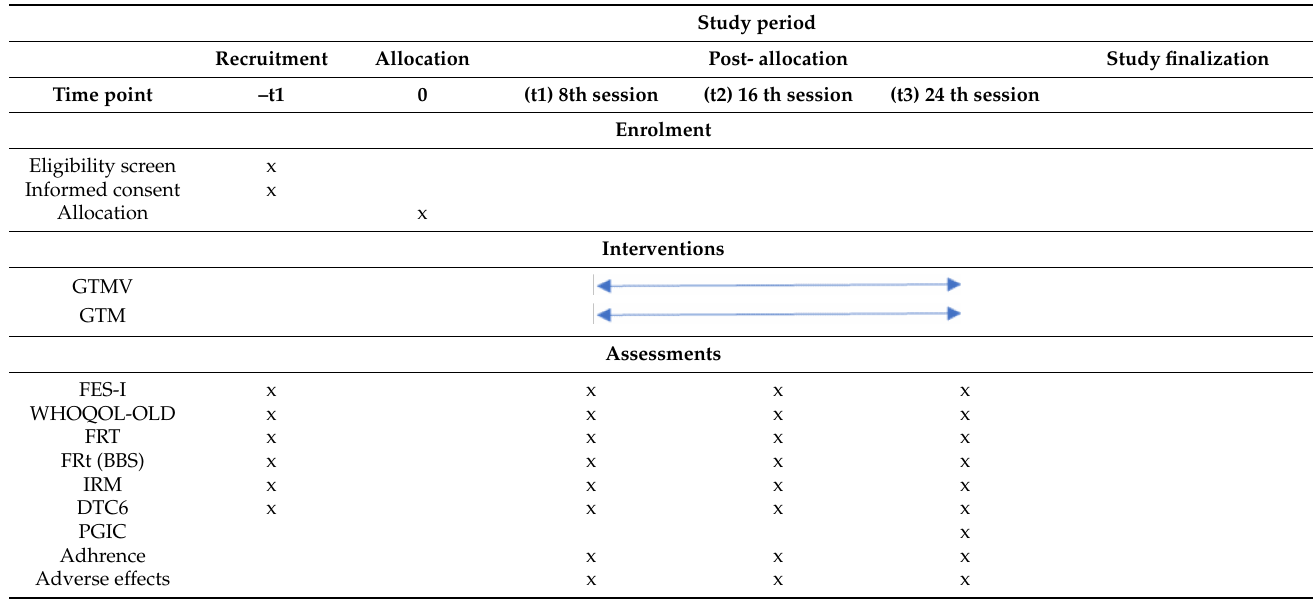
Table 3. Schematic diagram of timeline of enrollment, intervention, and assessments. Adapted from SPIRIT Group